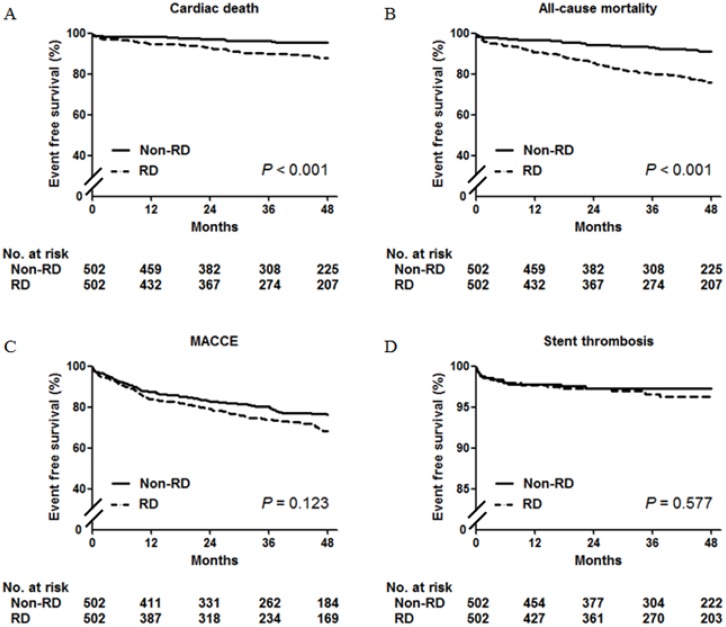
Kaplan-Meier curves for propensity-matched patients according to presence of renal dysfunction.Kaplan-Meier curves in propensity-matched patients for cardiac death (A), all-cause death (B), MACCE (C), and stent thrombosis (D) in the non- renal dysfunction (solid line) group versus renal dysfunction (dashed line) group. MACCE = major adverse cardiac and cerebrovascular event(s); RD = renal dysfunction.